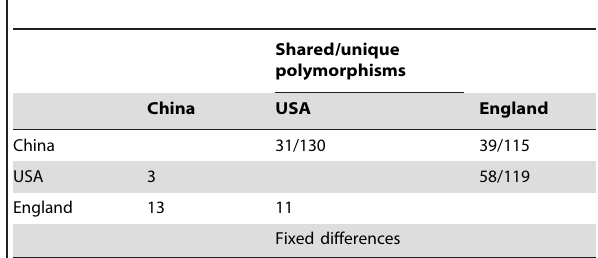
Table 6. Pairwise comparisons of RPB1 sequences between N. bombycis isolates, showing frequency of shared polymorphisms, unique polymorphisms and fixed differences.